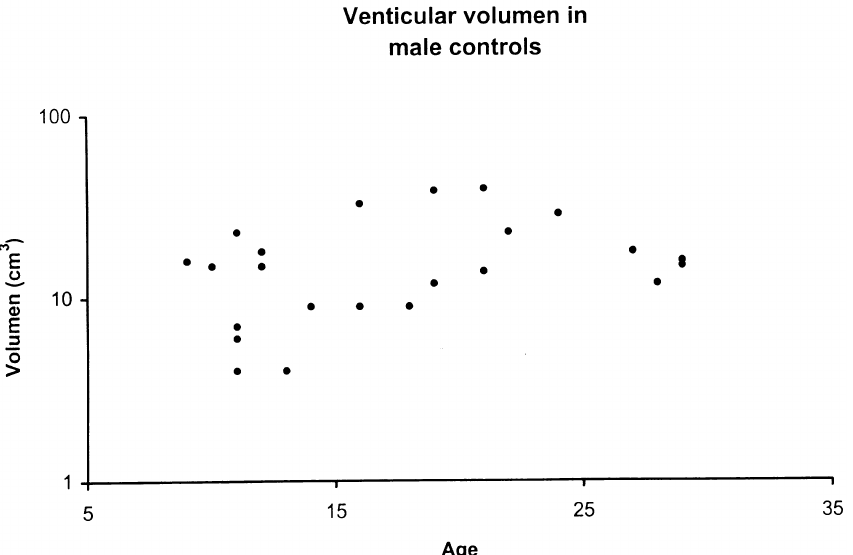
Fig. 3. Shows that there is no correlation between ventricular volume and age. The two largest volumes are found in control males, aged 19 and 21.